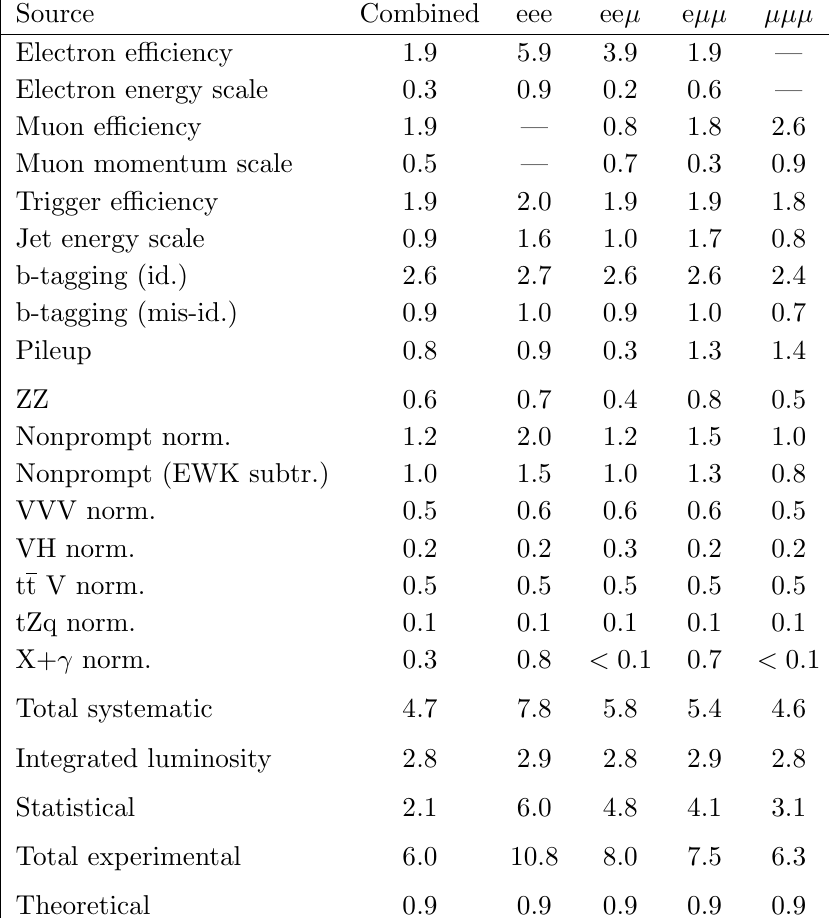
Table 3 . Summary of the total post(cid:12)t impact of each uncertainty source on the uncertainty in the signal strength measurement, for the four (cid:13)avour categories and their combination. Theoretical uncertainties are only included in the signal acceptance during the extrapolation to the total phase space, so they are not included in the likelihood (cid:12)t. The values are percentages and correspond to half the di(cid:11)erence between the up and down variation of each systematic uncertainty component.